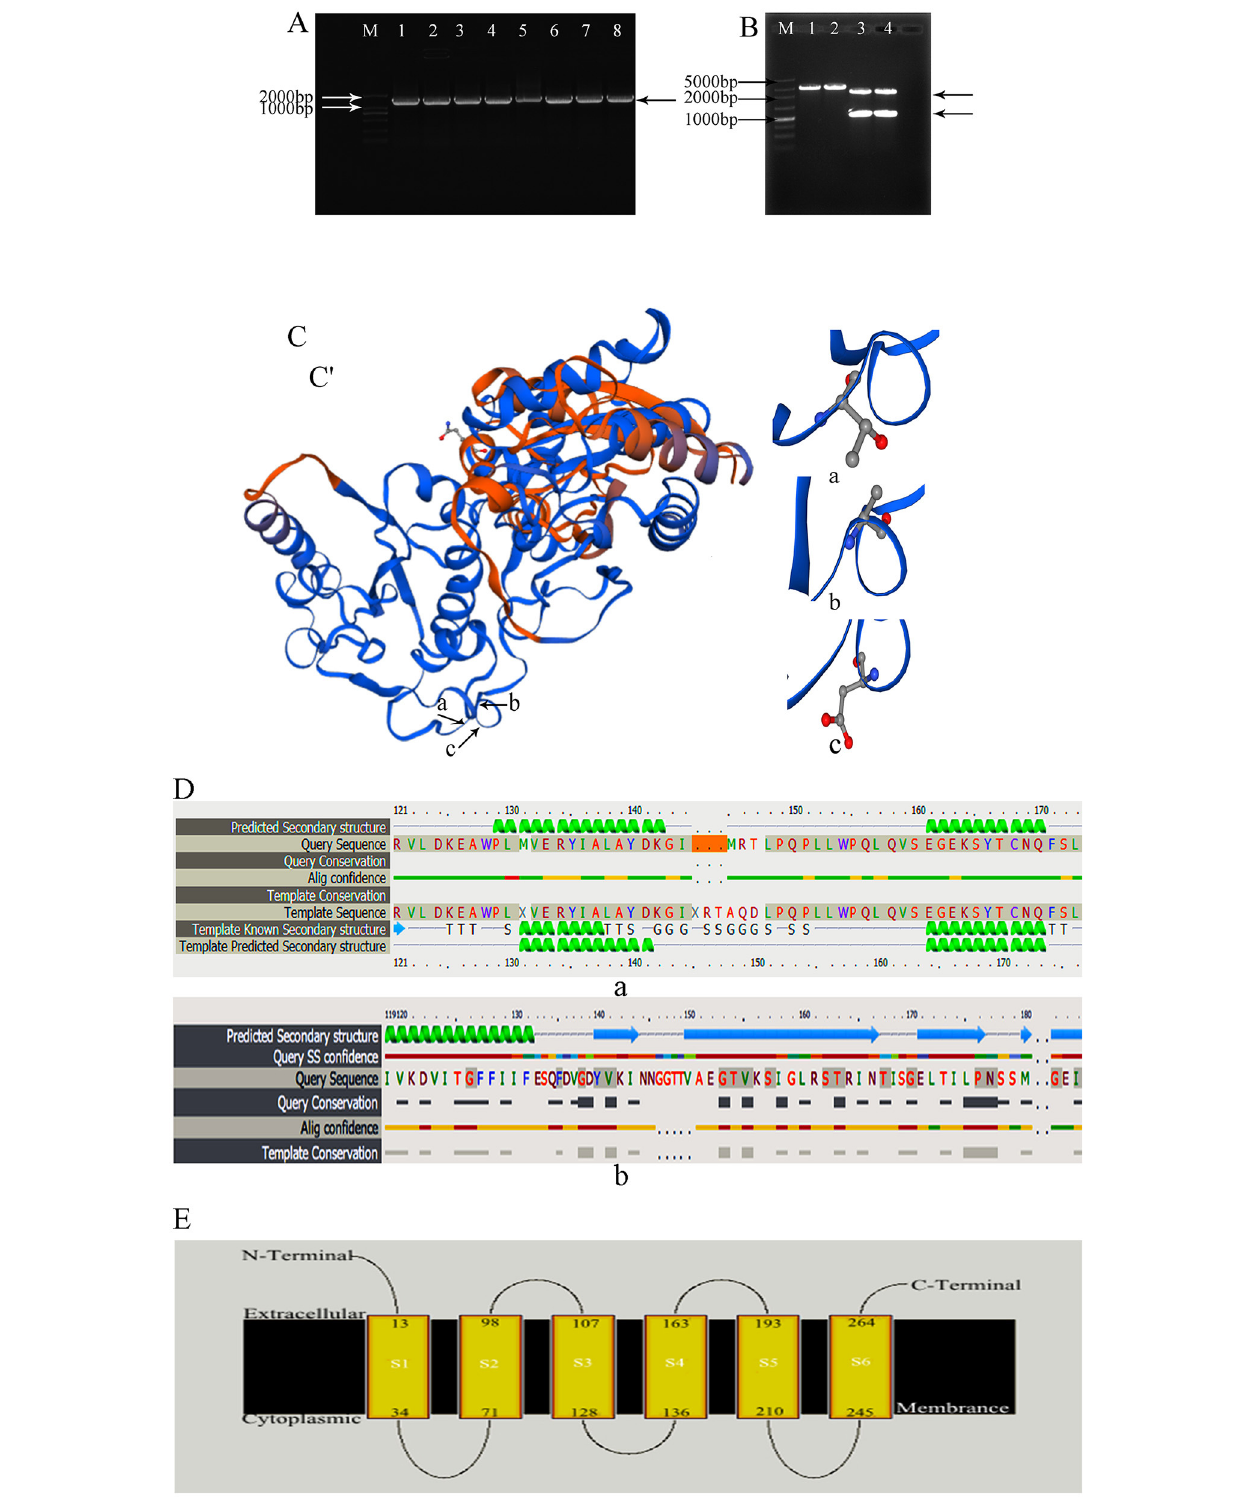
FIGURE 1 | (A) waaF gene amplification by PCR; M: 2,000 bp Marker. 1–8: amplified the waaF gene band which appeared near the 1,000 marker’s band. (B) Plasmid vector PGEM-T-waaF enzyme digestion; M: 5,000 bp Marker. 1, 2: pGEM-T-waaF plasmid; 3, 4: pGEM-T-waaF plasmid was digested by BamH and Kpn I, the